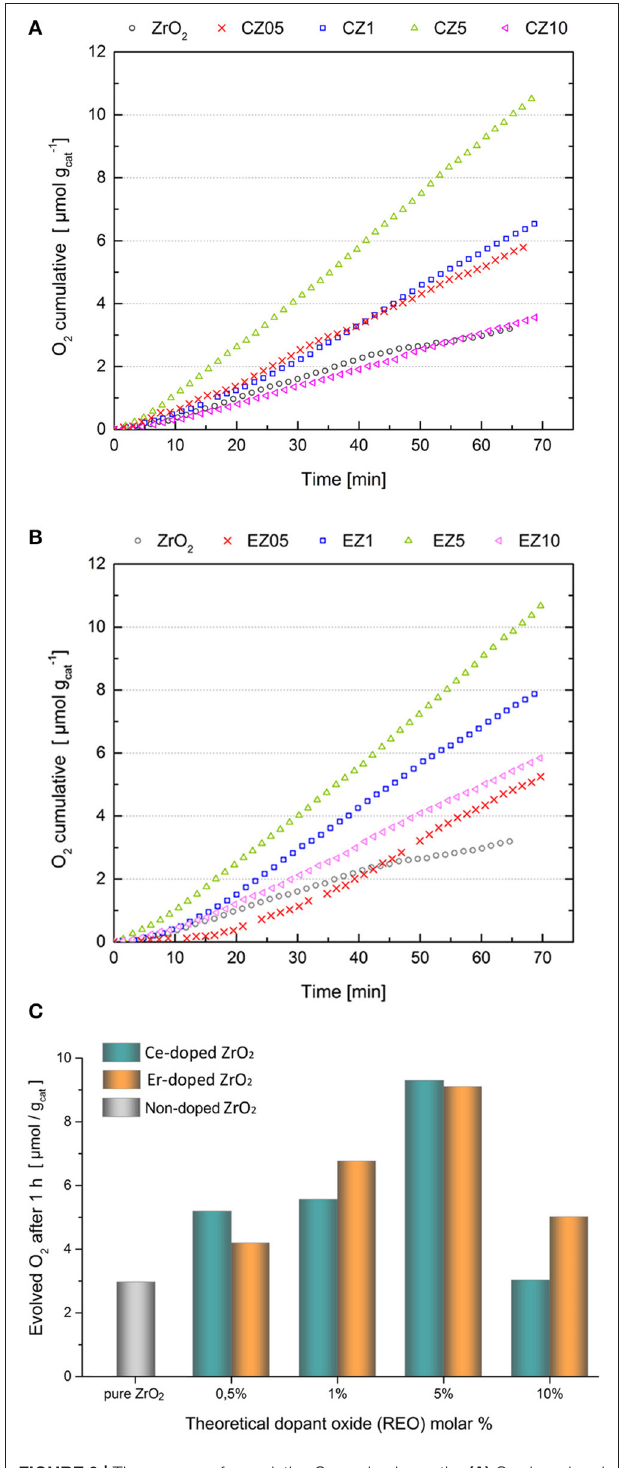
FIGURE 9 | Time course of cumulative O 2 evolved over the (A) Ce-doped and (B) Er-doped samples. (C) Total O 2 evolved per gram of catalyst after 1h of photocatalytic test of the RE-doped ZrO 2 samples. Dopant molar percentages of 0.5, 1, 5, and 10% on a REO base. Photocatalytic test conditions: 100mg of catalyst, 110ml of 50mM AgNO 3 solution, simulated solar light irradiation (AM 1.5G, 100 mW cm − 2